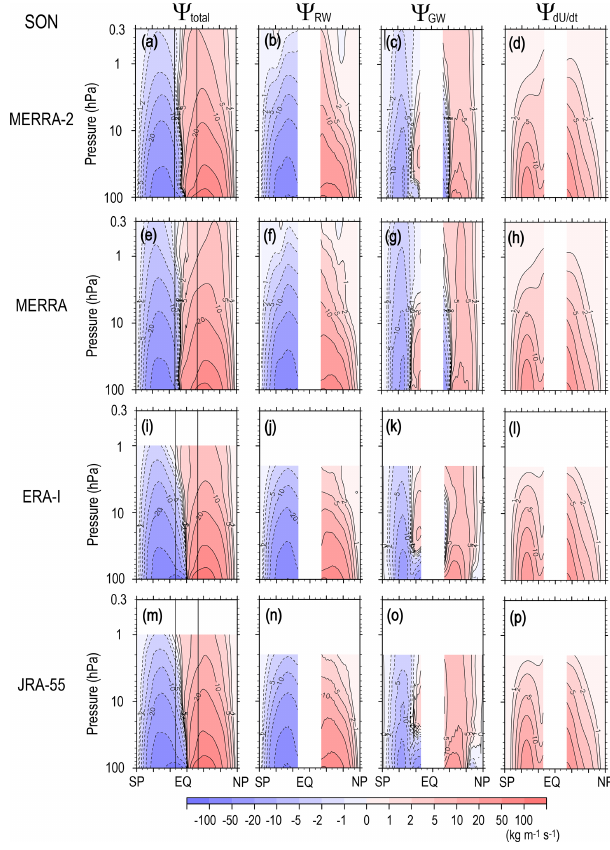
Figure 9. The same as Fig. 6 but for SON.